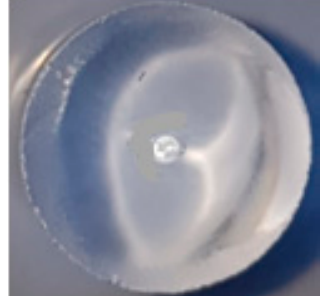
Figure 5 . Cross-sectional view of Al 2 O 3 + Er 2 O 3 doped fiber preform section for electron probe microanalysis (EPMA) where the central bright portion represents the doping region.